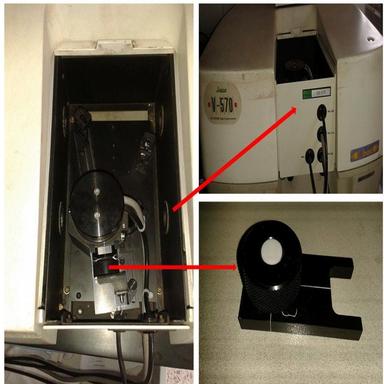
The Integrated sphere unit in the UV–Vis-NIR-scanning spectrophotometer (JASCO V-570 spectrophotometer, Japan).